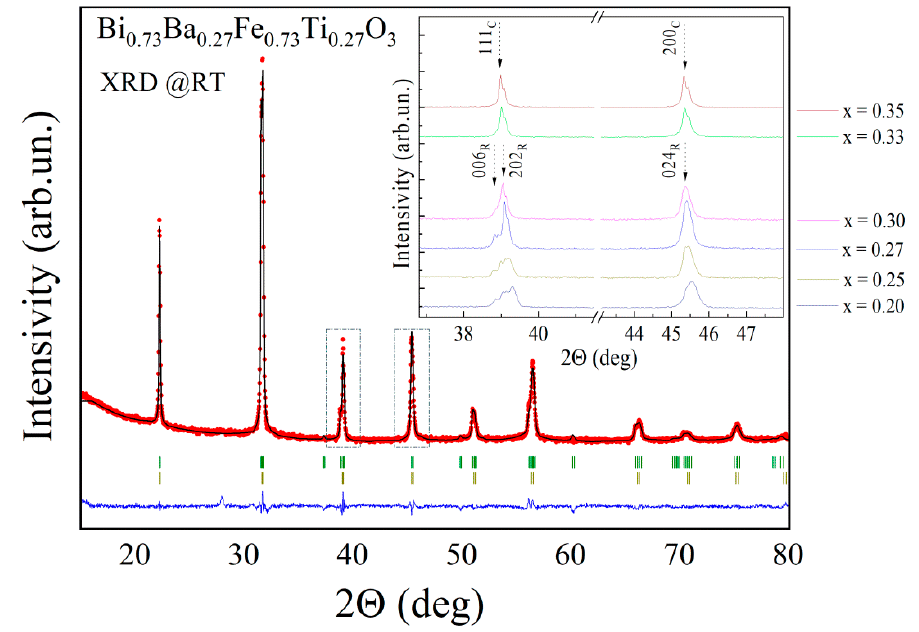
Figure 1. Room-temperature XRD pattern of compound Bi 0.73 Ba 0.27 Fe 0.73 Ti 0.27 O 3 . Observed and calculated profiles are marked by dots and solid line, respectively; the line below the pattern refers to the difference between the profiles. The upper row of the ticks denotes Bragg reflections ascribed to the rhombohedral phase, the second row—to the cubic phase. The inset shows concentration-driven evolution of the selected diffraction peaks.